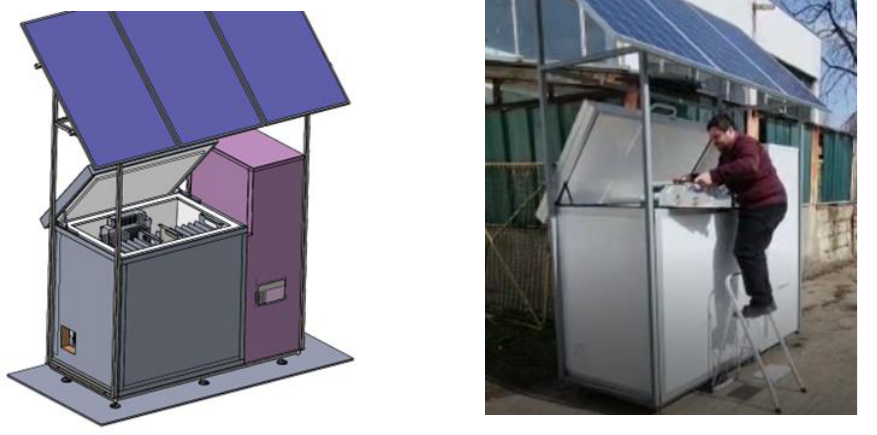
Figure 2. Loading process with the product tray opened.